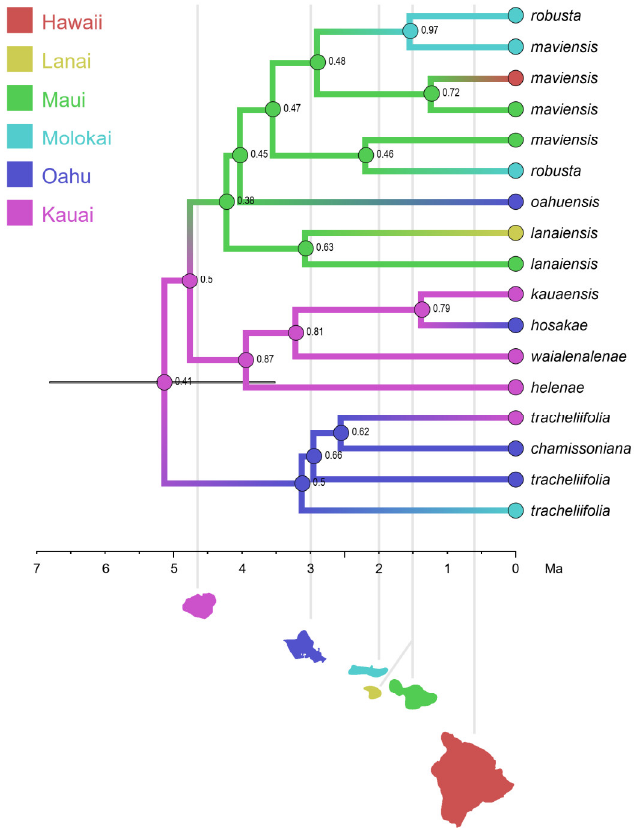
Figure 25. Historical biogeography of the Hawaiian violets, Viola subsect. Nosphinium , based on ITS sequences and simultaneous estimation of phylogeny and discrete biogeography using BEAST. Kauai is indicated as the most likely island of colonisation, based both on age, which excludes all the other islands, and on receiving the highest posterior probability ( pp ) by ancestral state reconstruction. The 95% credibility interval for node age is shown as a node bar on the crown node. Ancestral states are colour-coded according to island and indicated on each node along with the pp . Each island is shown as a silhouette and its age is indicated by a vertical line. Outgroups have been trimmed.